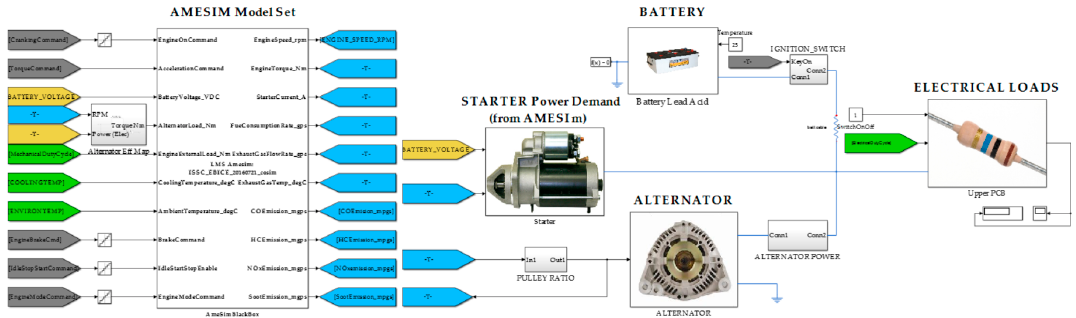
Figure 3. Complete Simulink plan model using AMESim and Simscape.